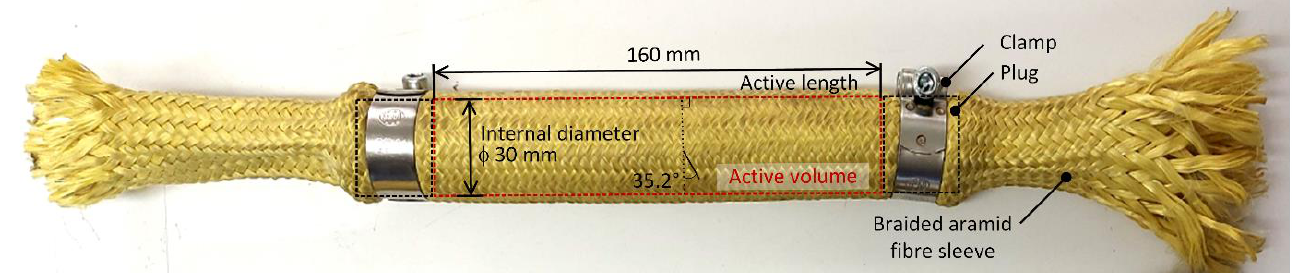
Figure 5. Braided aramid fibers sleeve specimen, including two stainless steel clamps and two